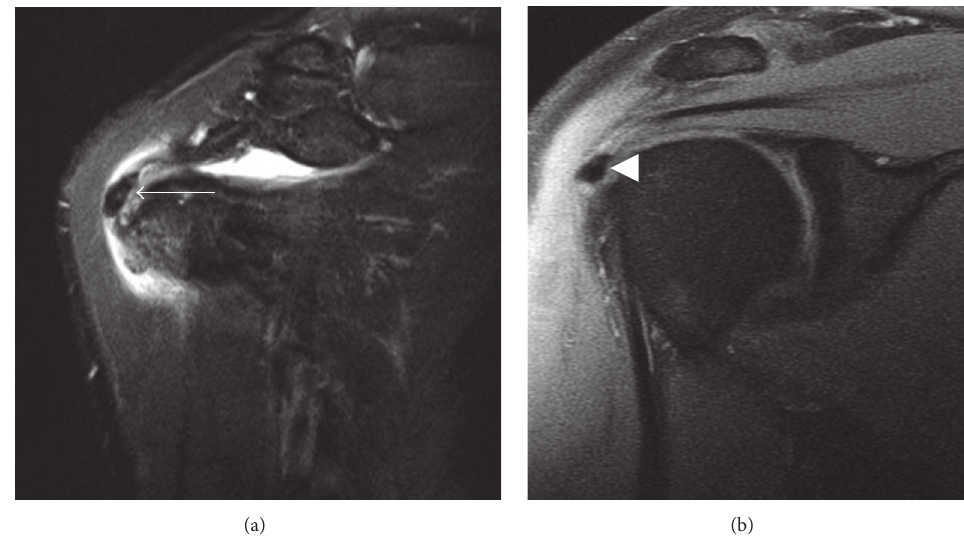
Figure 3: MRI appearance of calcific tendinopathy. (a) The acute, symptomatic phase of calcific tendinopathy is often associated with soft tissue edema surrounding the tendon calcifications (arrow). (b) In the chronic phase of calcific tendinopathy, calcifications are typically more well defined and homogeneously low in signal intensity without surrounding edema (arrowhead).